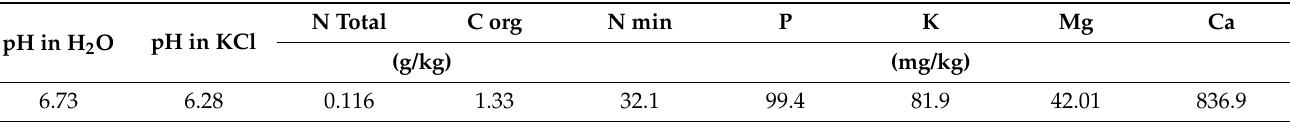
Table 2. Properties of the soil on which the experiment was